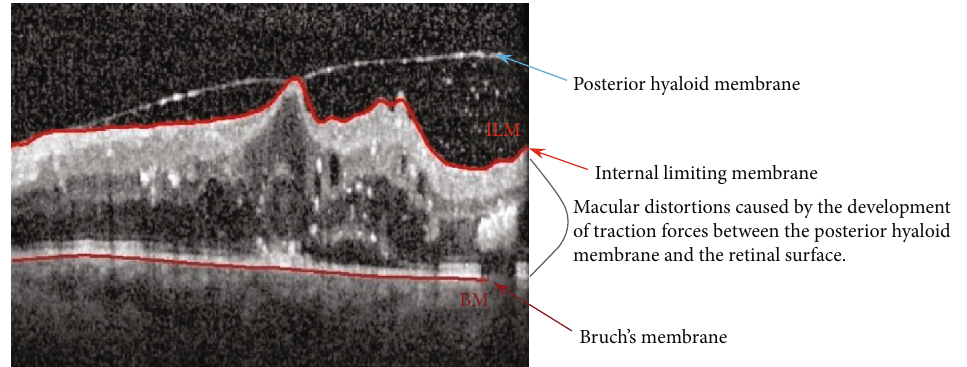
Figure 5: OCT aspects of the vitreomacular interface showing taut posterior hyaloid membrane with subsequent macular